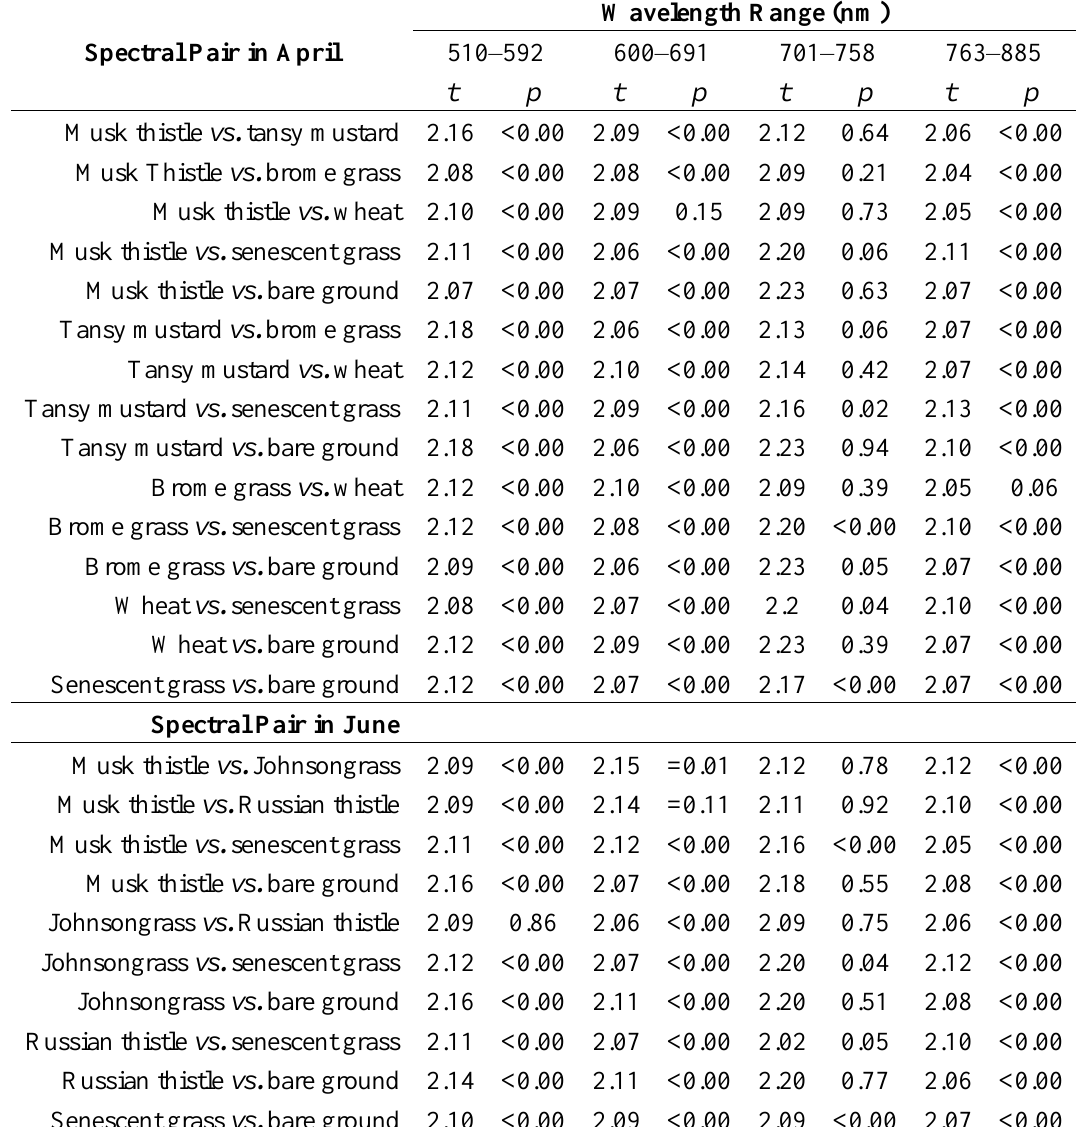
Table 3. Paired t -test comparison of the mean reflectance spectra of training samples for land cover classes. The training samples were manually extracted from April and June images over the visible and near infrared (510–885 nm) wavelengths.